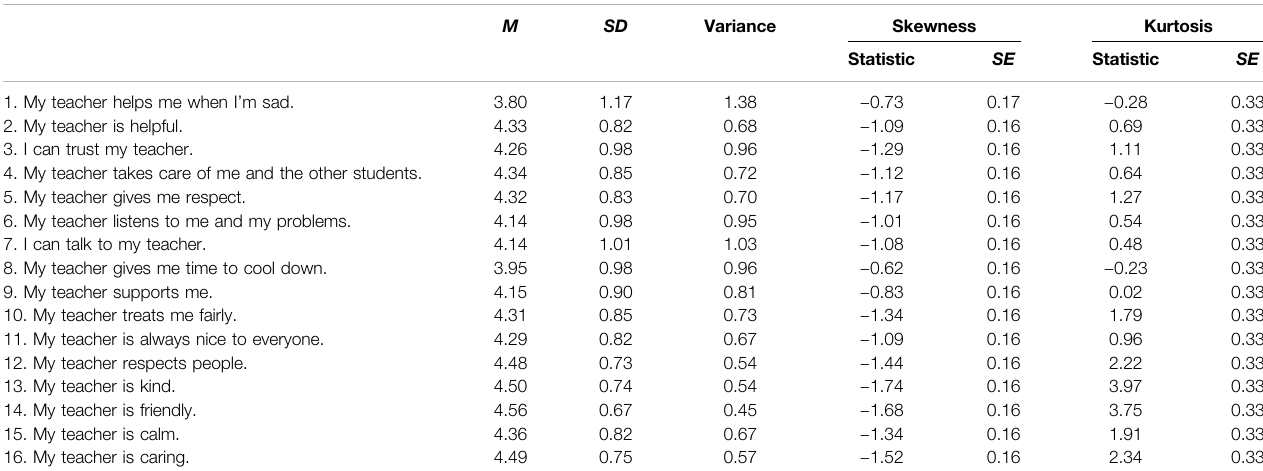
TABLE 2 | Descriptive statistics of the